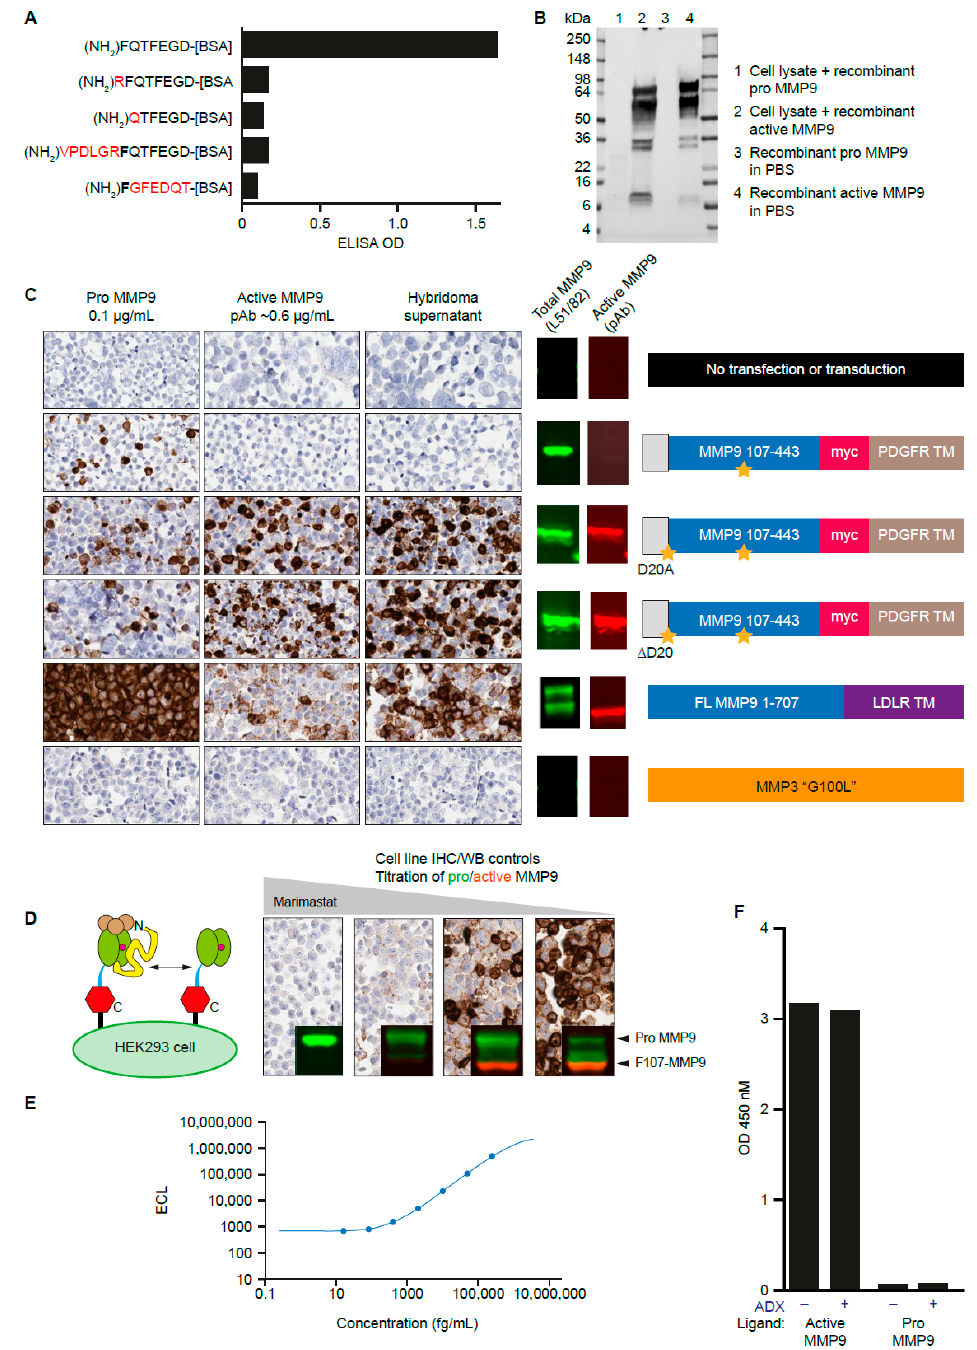
Figure 2. Discovery and characterization of antibodies directed at the active MMP9 neoepitope. ( A ) Hybridoma supernatants specific for the N-terminus of MMP9 after cleavage between Arg106 and Phe107 were identified by direct ELISA toward the corresponding on-target and off-target peptides. ( B ) Pro-MMP9 and active-MMP9 protein standards in buffer or cell lysate were probed with candidate hybridoma supernatants by Western blot. The multiple bands represent the multiple degradation products of MMP9. ( C ) Antibodies that reacted with FFPE cell pellets engineered to contain the active MMP9 neoepitope were identified. Orange stars indicate point mutations, either at the signal peptide junction with F107 (D20A or D20 deletion engineered to generate the F107 neoepitope; see Appendix A) or a mutation in the catalytic domain rendering MMP9 inactive. PDGFR TM and LDLR TM refer to transmembrane domains of PDGFR and LDLR, respectively. MMP3 G100L is an active form of MMP3, a negative control. Molecular weights of bands shown correspond to Figure 1. ( D ) Specificity of the candidate IHC antibodies were determined using cell pellets in which the pro-MMP9:active MMP9 ratio was titrated using marimastat (0.025–2.5 μ M). Inset Western blot images fall between the 98 and 62 kDa molecular weight markers. ( E ) A sandwich ELISA using anti–active MMP9 antibodies paired with total MMP9 antibody detected active MMP9 in diluent with a sensitivity < 1 pg/mL. ( F ) ADX does not interfere with the sandwich ELISA for